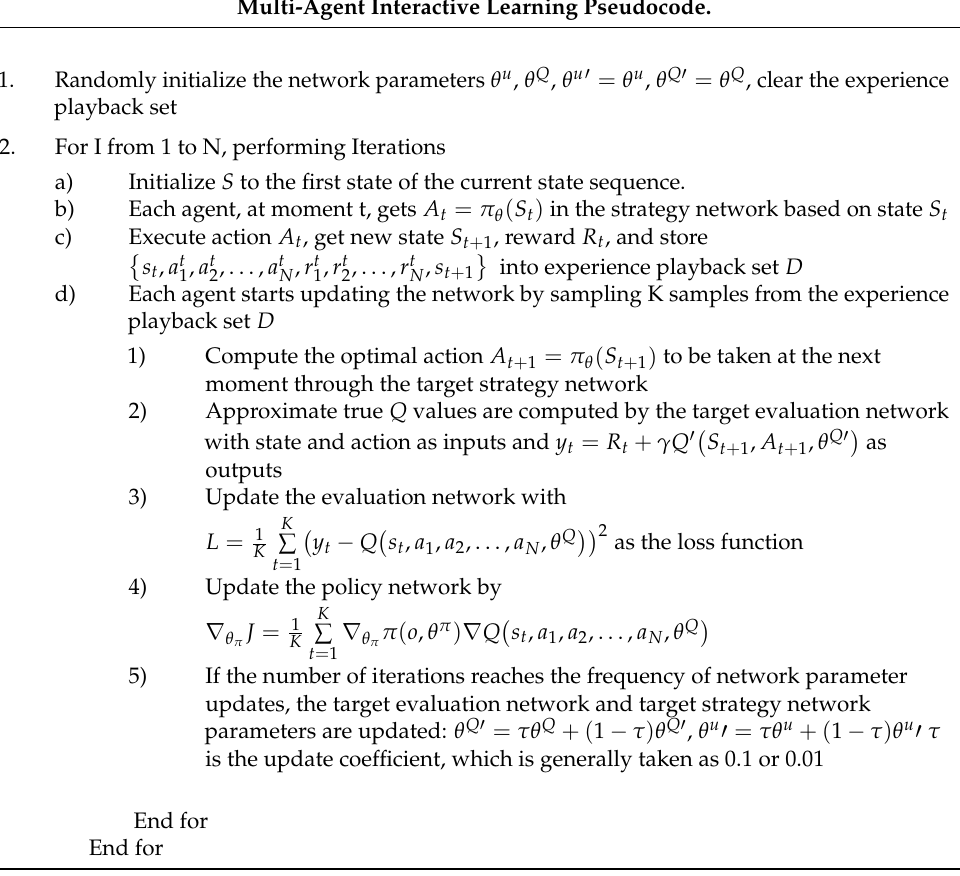
Table 1. Multi-agent interactive learning pseudocode. Multi-Agent Interactive Learning